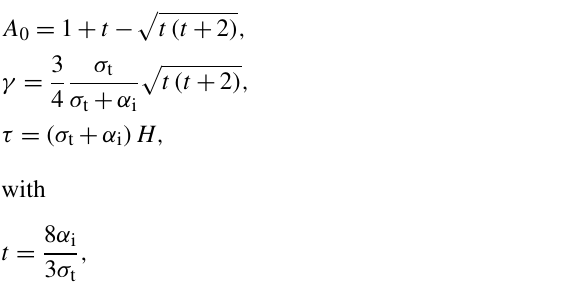
. The ratio of b and the average cosine g are b